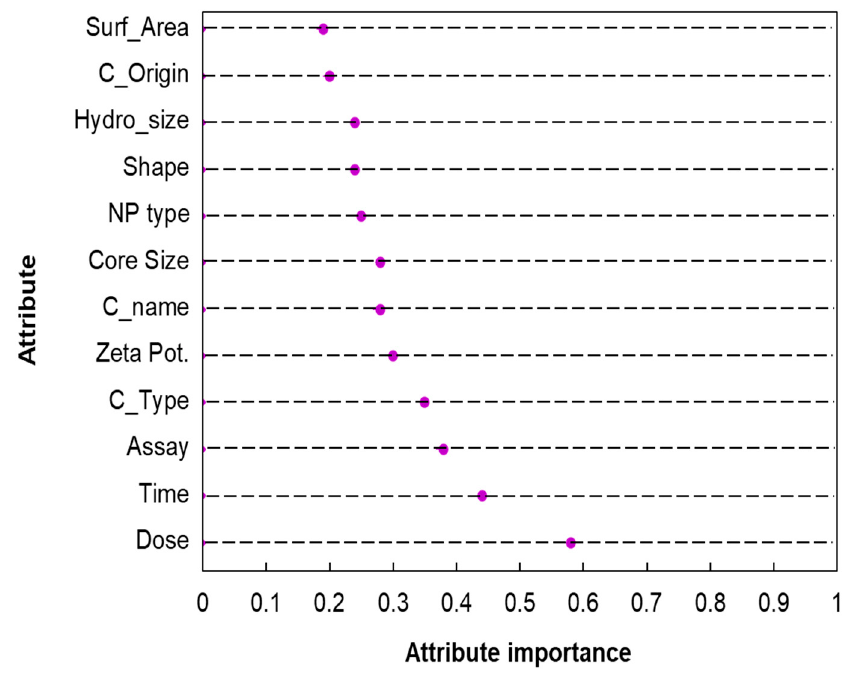
Figure 4. Attribute importance evaluation based on models’ information gain.